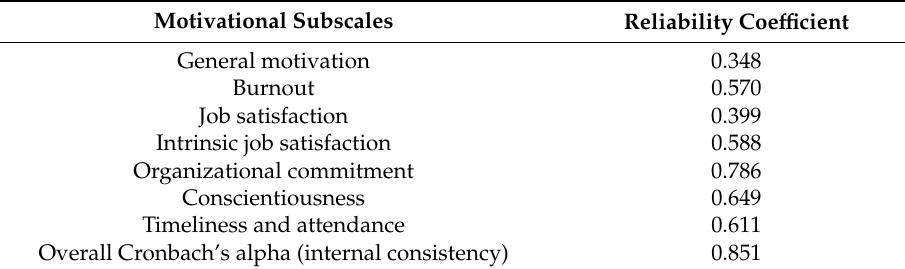
Table A1. Reliability coe ffi cients of the motivational